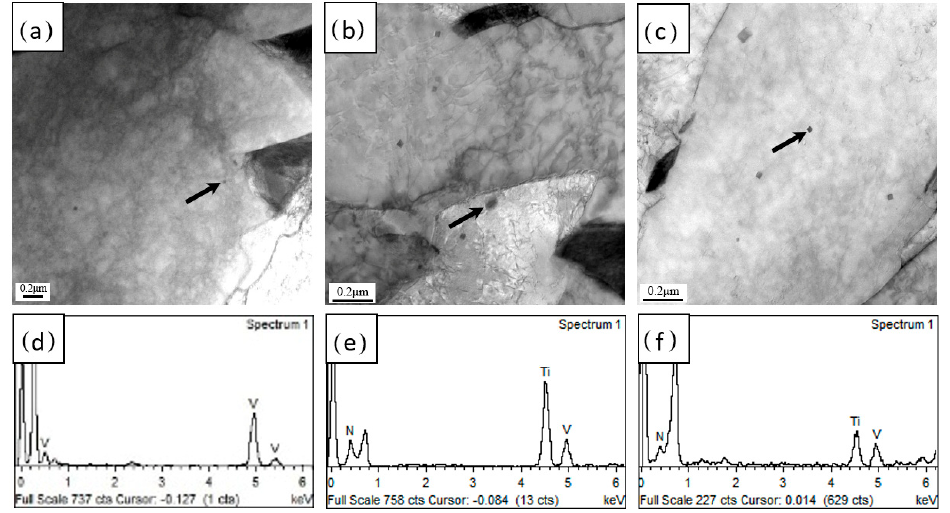
Figure 8. Typical TEM micrographs of precipitates in different CP samples and corresponding EDX analyses at CP ‐ A ( a , d ), CP ‐ C ( b , e ), CP ‐ E ( c , f ). The XRD spectra corresponding to different CP samples were presented in Figure 9. With this XRD spectrum used, the dislocation density, ρ , was calculated using the following equation.